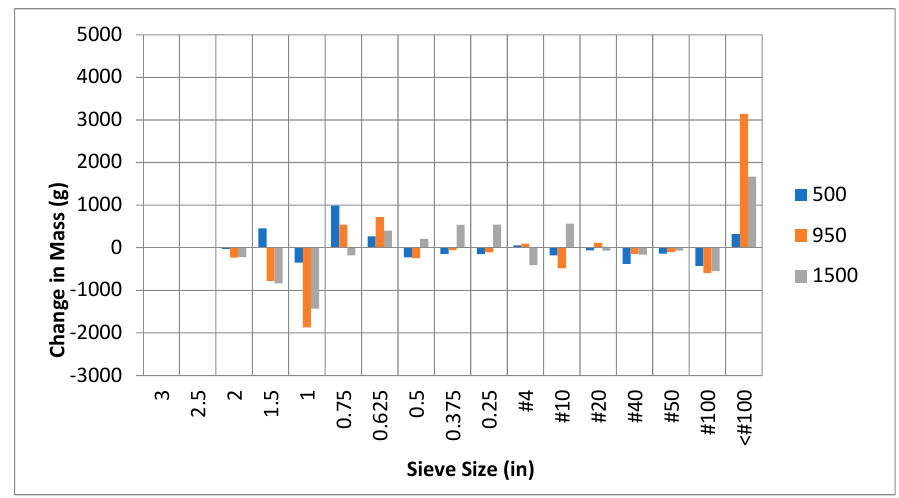
Figure 4. Mass flow of low-quality aggregate sample averages by loading intensity. 219